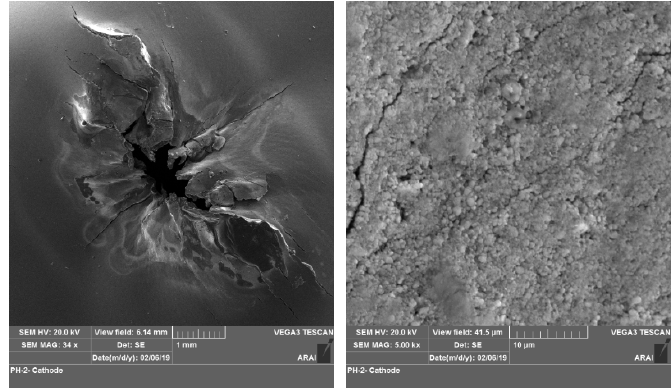
Figure 8. Nail-penetrated cell cathode with location at centre (50% SoC).